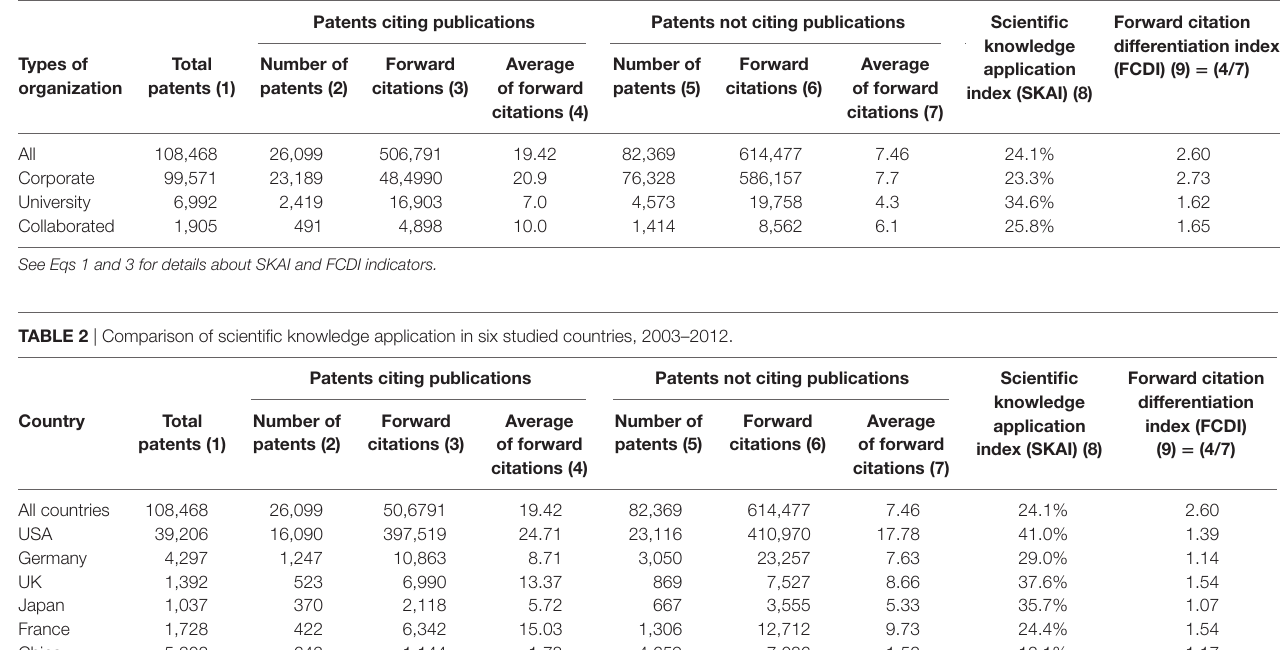
TaBle 1 | Comparison of scientific knowledge application by organization type,